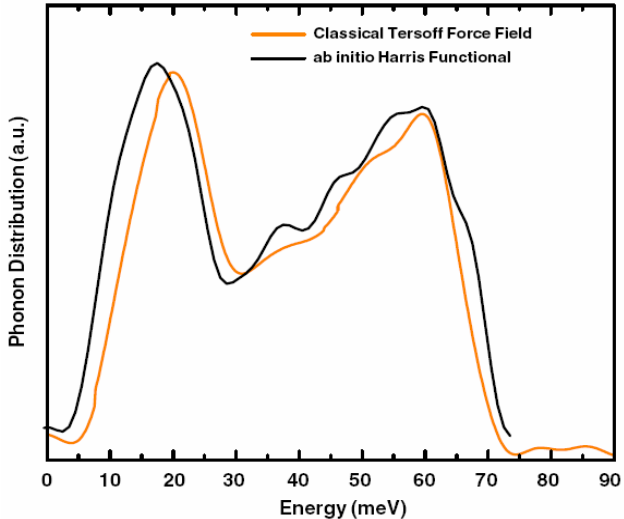
Figure 43. Comparison between the quantum (Harris, black curve) and the classical (Tersoff, orange curve) vDOS for the 216-atom ab initio generated a -Si network